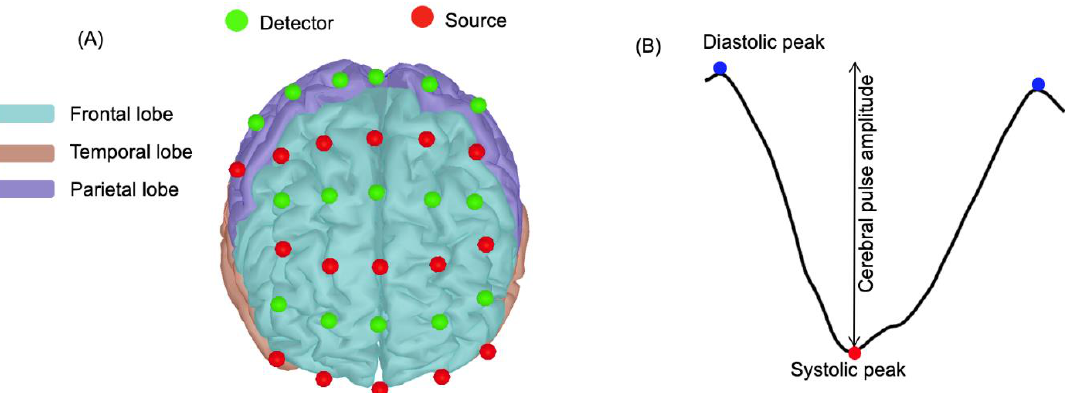
Figure 1. ( A ) Frontal view of the source and detector placements on the Colin27 template. Red dots represent the NIRS sources, and green dots represent detectors. The source and detector arrangement covered frontal and parietal cortex subregions. ( B ) Example of a single cerebral pulse waveform for a channel of a participant. The change in intensity between the systolic (red dot) and the diastolic (blue dots) peaks represents cerebral pulse amplitude (adapted from [24]). x -axis is time (s) and y -axis is NIRS signal